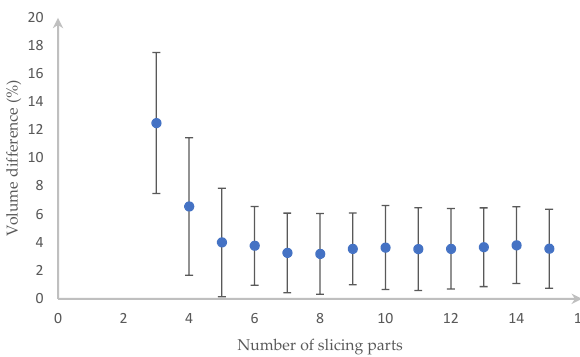
Figure 15. Percentage errors when slicing the carrot into 3 to 15 parts.